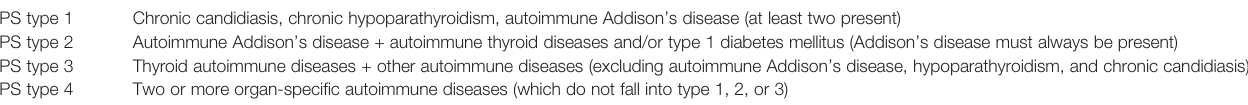
TABLE 3 | Classi fi cation of autoimmune polyglandular syndrome (APS) according to Neufeld and Blizzard (2, 4, 8). APS type 1